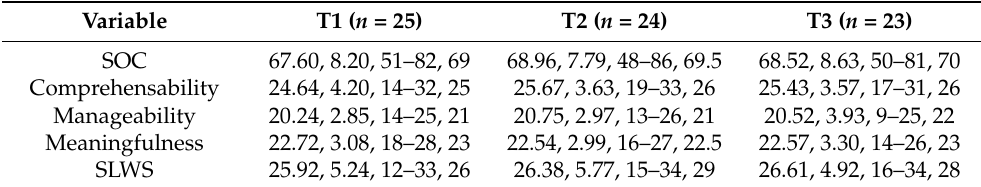
Table 4. Average scores in SOC and SLWS among the participants at baseline (T1), 4 months after baseline (T2), and 13 months after baseline